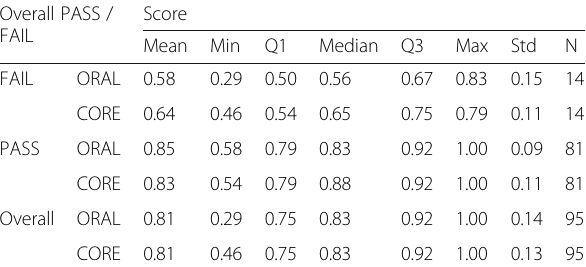
Table 3 Distribution of the scores of the oral and CORE sections when candidates passed or failed the overall exam Overall PASS / FAIL